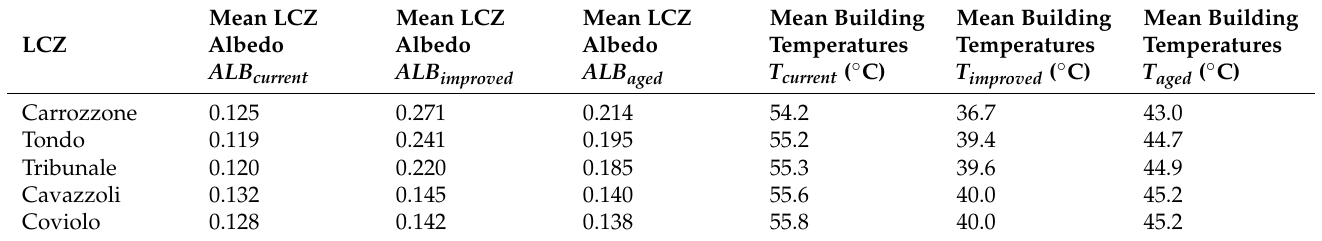
Table 8. Comparison of albedo values in the three scenarios: current, improved, and aged for each LCZ. Comparison of building roof temperatures in the same scenarios.